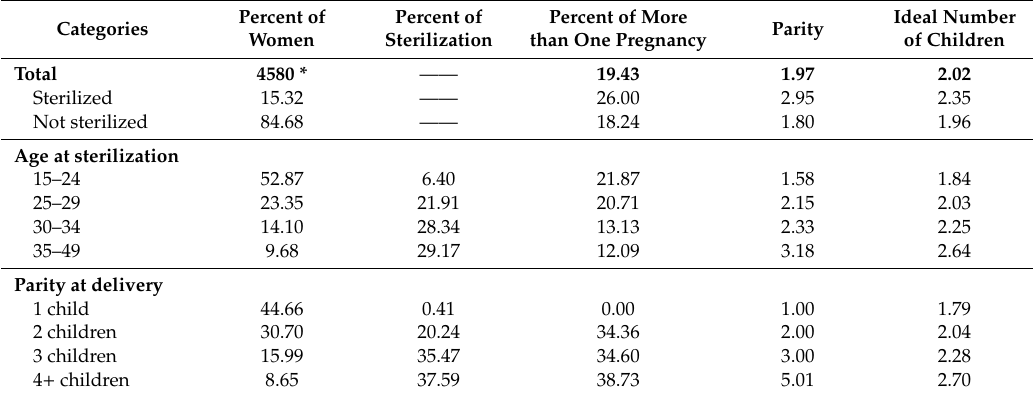
Table 1. Distribution of women by sterilization situation, age at the moment of sterilization, and parity at the moment of the last delivery, Brazil, January 2001 to July 2007.